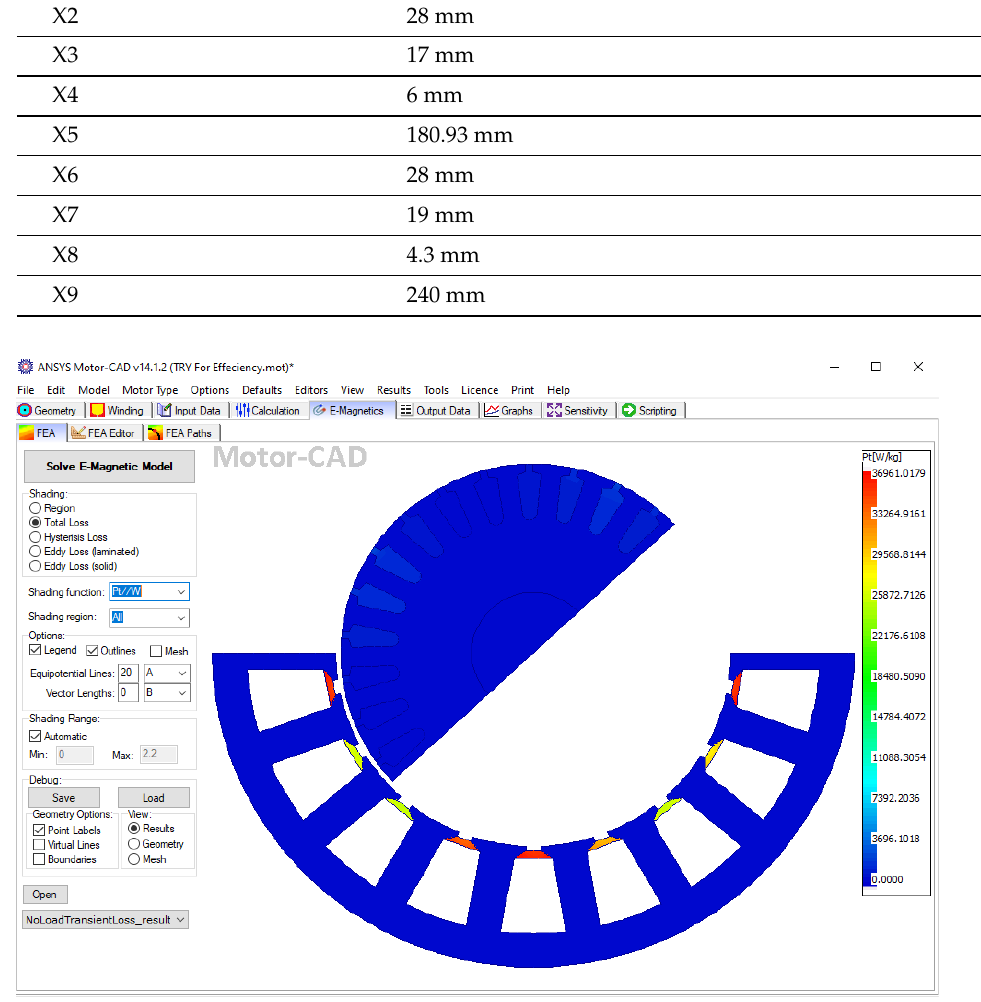
Figure 11. Loss per Weight of Designed